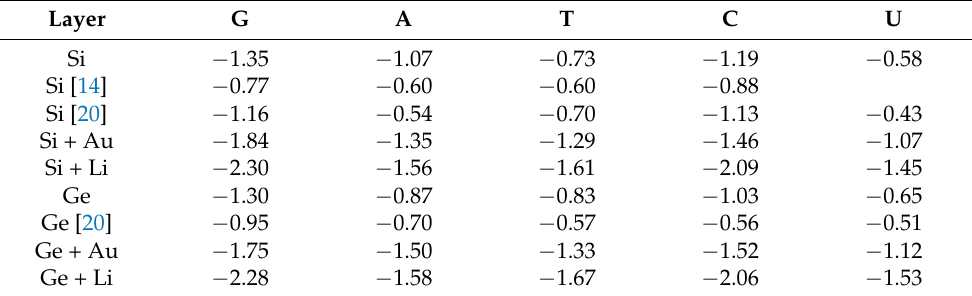
Table 1. Binding energies of nucleobases on bare and Li/Au-supported silicene and germanene. Binding values are in eV. Negative binding energies indicate stable